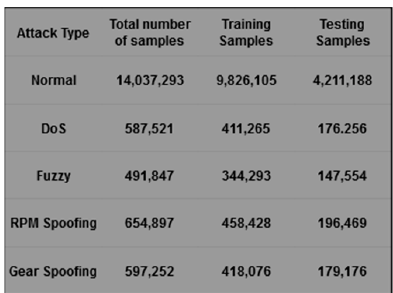
Figure 7. NSL-KDD dataset description.